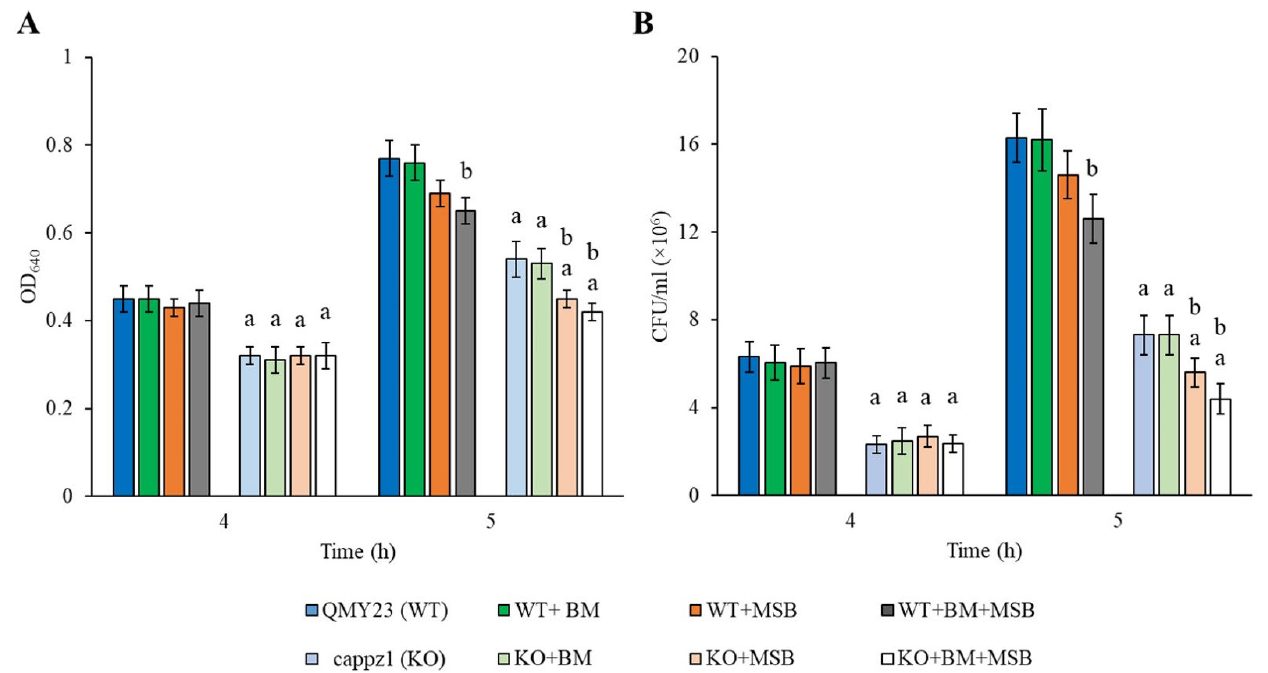
Figure 1. The physiological effect of C. albicans protein phosphatase Z1 ( CaPPZ1 ) gene deletion, betamethasone (BM) treatment or/and oxidative stress on the growth rate of QMY23 (WT) and cappz1 mutant (KO) C. albicans strains. Selected cultures were supplemented with 2 mM BM at 0 h incubation time and oxidative agent (+1.5 mM MSB) at 4 h incubation. The effect of treatments was followed by measuring the optical density (OD 640 ) ( A ) and colony forming unit (CFU) ( B ) after 4th and 5th of culturing. Mean ± SD values calculated from three independent experiments are presented. a and b indicate significant differences at p < 0.05 significance level in comparison to WT strain (untreated KO vs. untreated WT and treated KO vs. treated WT) and to untreated controls (treated WT vs. untreated WT and treated KO vs. untreated KO),